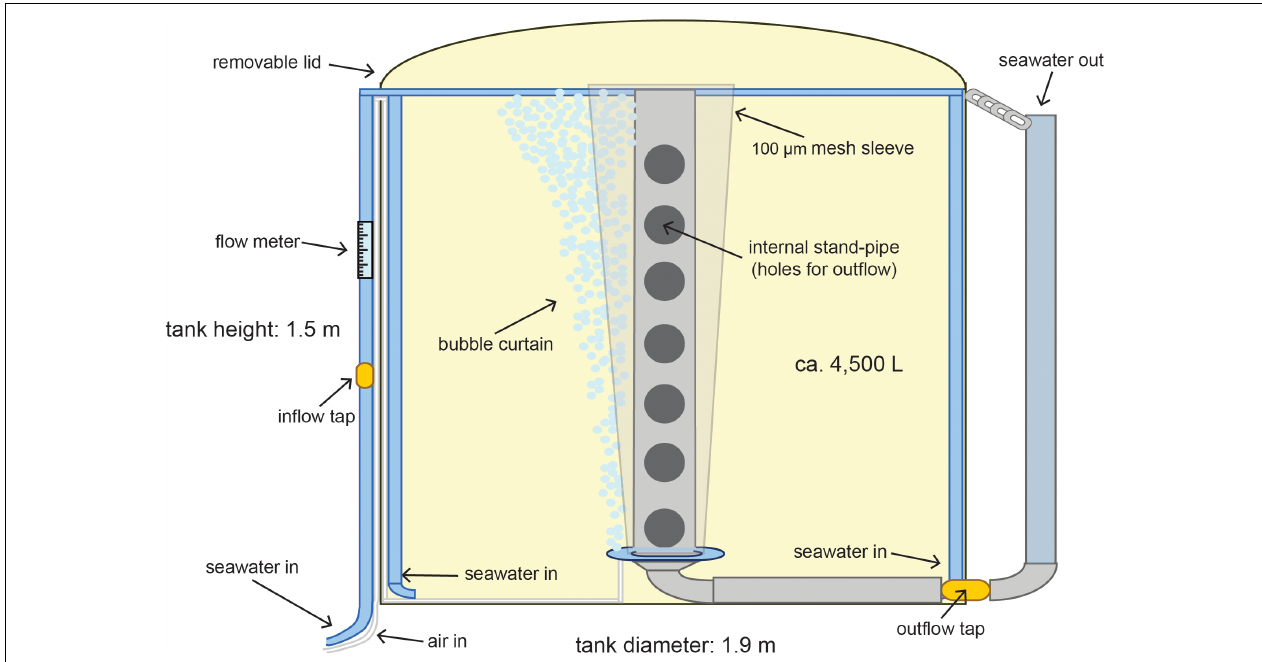
FIGURE 3 | Detail of tank design for flow-through rearing of the coral larvae. The water is circulated by the two opposing inflows and mixed from the flow of bubbles. The cone shaped mesh provides a large surface area that prevents larvae being lost to the outflow holes on the internal standpipe while the bubble curtain prevents them sticking to the mesh.